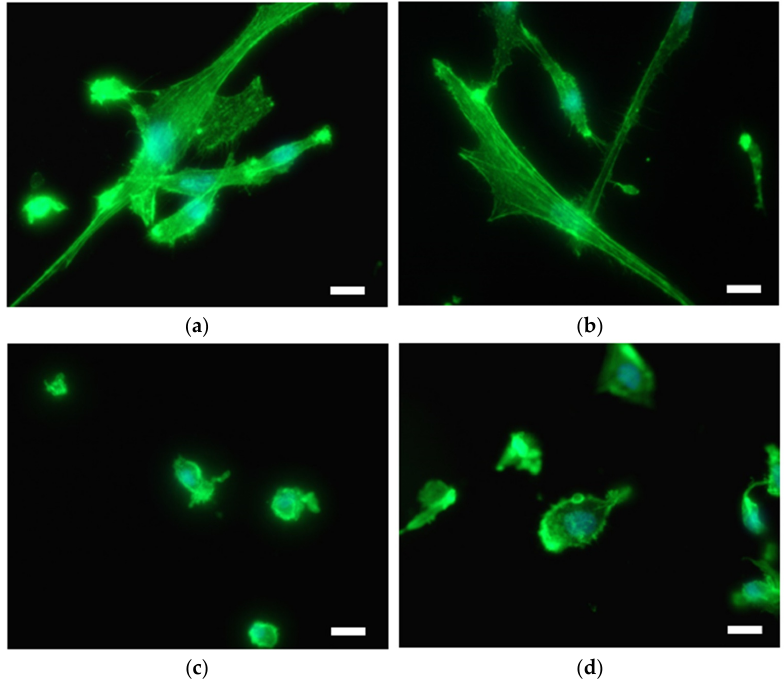
Figure 6. SMC on the surface of ( a ) Ti foil, ( b ) plasma-treated Ti foil (Ti + P), ( c ) hydrothermally treated Ti foil (Ti HT) and ( d ) hydrothermally/plasma-treated Ti foil (Ti HT + P), determined by immunofluorescent microscopy. F-actin is shown in green (Fluorescein Phalloidin). Nuclei are vis- ualized with DAPI (blue color). Scale bar = 25 µm.